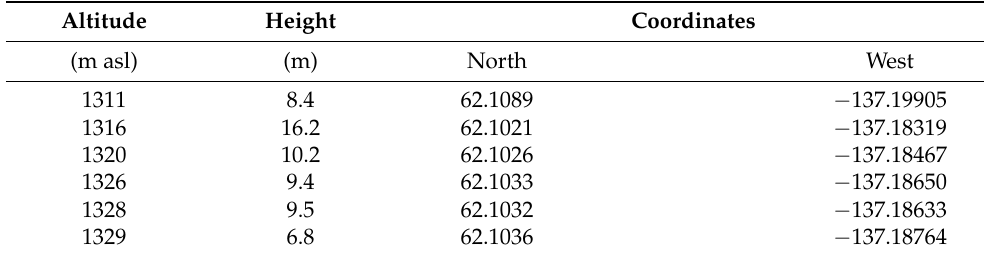
Table 1. Altitudes, trunk lengths and locations of the six investigated trees. Altitude Height